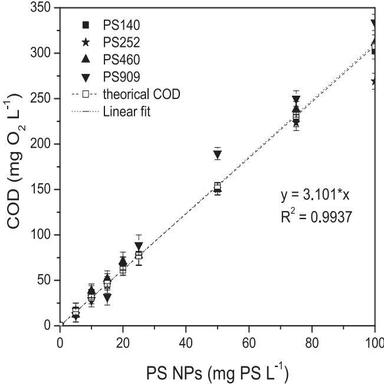
Calibration curve of Chemical Oxygen Demand (COD) vs. PS NPs concentration ( = 0 − 100 mg/L and D0 = 140, 252, 460 and 909 nm).